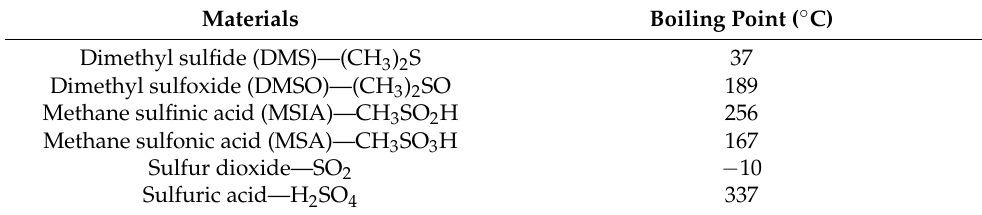
Table 1. DMS and its major oxidation products and boiling points. Materials Boiling Point ( ◦